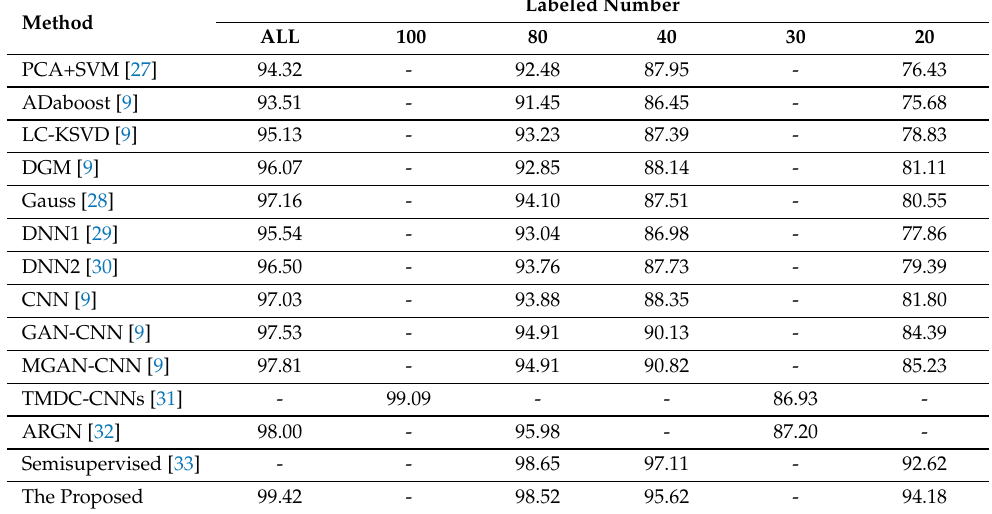
Table 9. Recognition accuracy (%) under different numbers of labeled